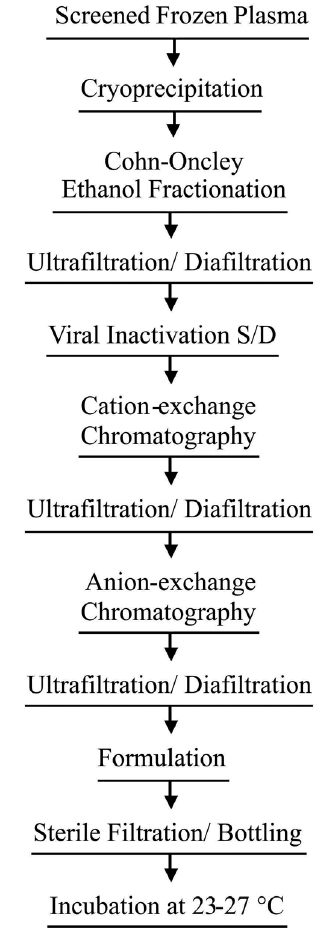
FIGURE 1 - Purification process for anti-dengue specific IgGs (Oncley et al ., 1949; Lucena et al. ,